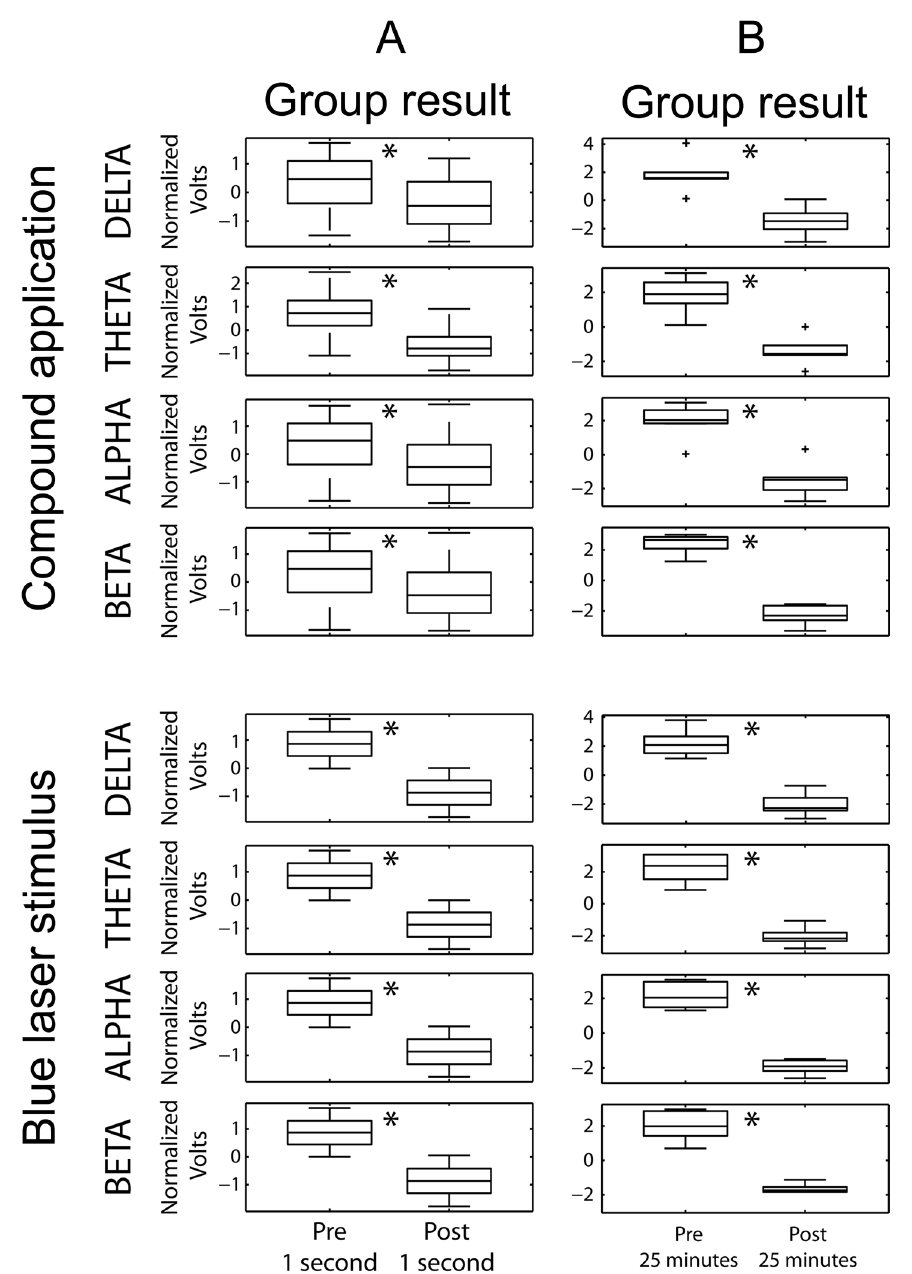
Figure 2. Short- and long-term effects of the infusion and photorelease of caged γ-amino-butyric-acid (GABA). A , Boxplots evaluating short-term effects of compound application and light stimulus (N = 3 mice). Calculation of the amplitude envelope in wavelet-filtered bands allows for high temporal resolution. We show that local field potential (LFP) amplitude distribution of windows of 1 s pre- and post-transitions are statistically different (pre vs post, *P < 0.000001, Mann-Whitney-Wilcoxon test). B , Boxplots show the long-term changes in the LFP voltage amplitudes in 4 frequency bands for 3 mice at transition times. Each boxplot represents voltage levels within a specific frequency band calculated by fast Fourier transform in ten non-overlapping 2.5-min windows. Thus, 25-min pre- and post-compound application and light stimulus are evaluated. All transitions differed significantly, in - dicating long-term effects of both compound application and laser pulse stimuli on LFP power (*P < 0.0043, Mann-Whitney-Wilcoxon